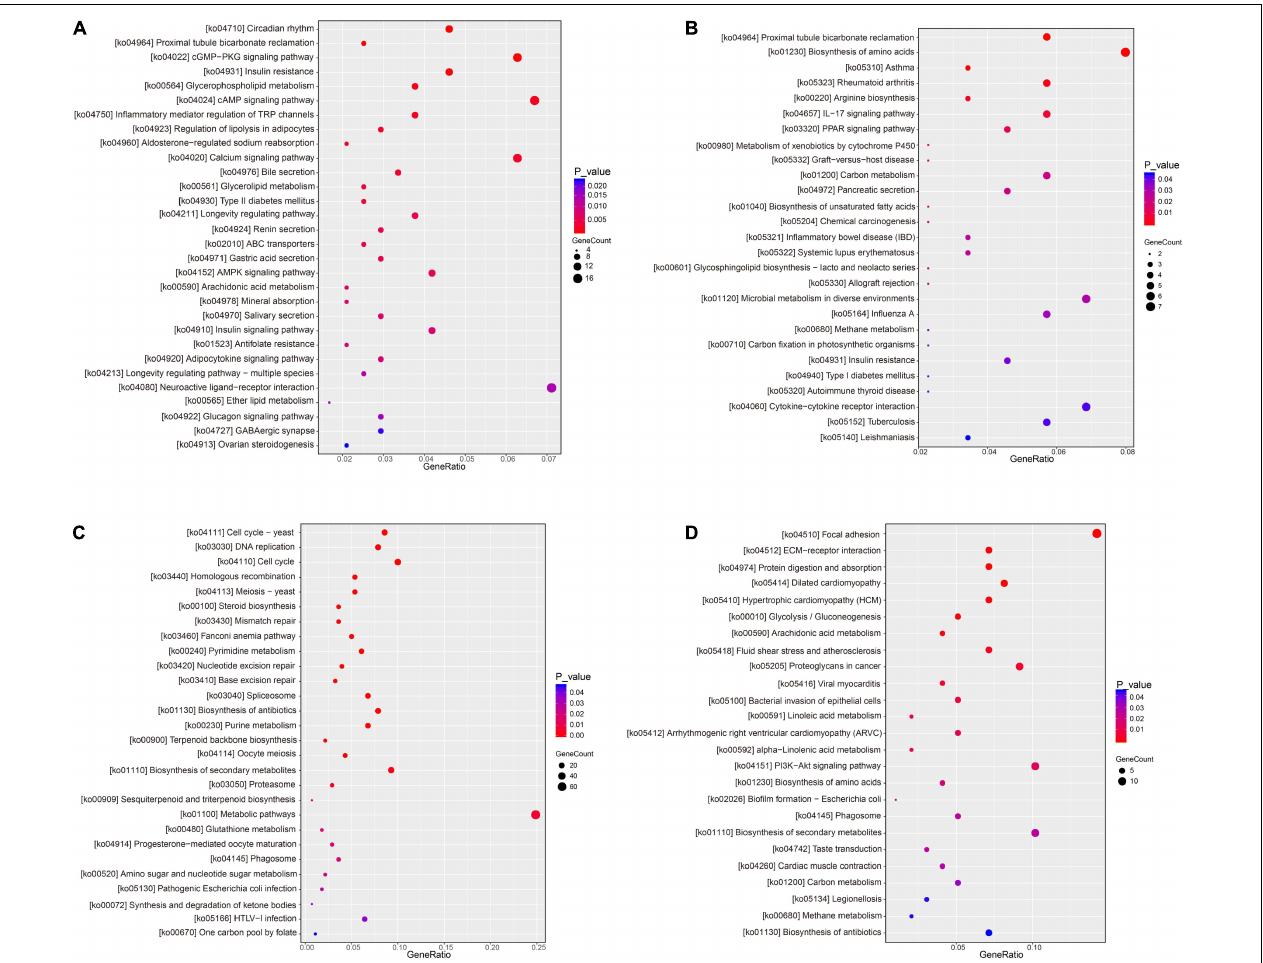
FIGURE 7 | Dot plot of KEGG pathway enrichment of DEGs. (A) RSHG versus RCG dot plot of up-regulated DEGs; (B) RSLG versus RCG dot plot of up-regulated DEGs; (C) RSHG versus RCG dot plot of down-regulated DEGs; and (D) RSLG versus RCG dot plot of down-regulated DEGs.